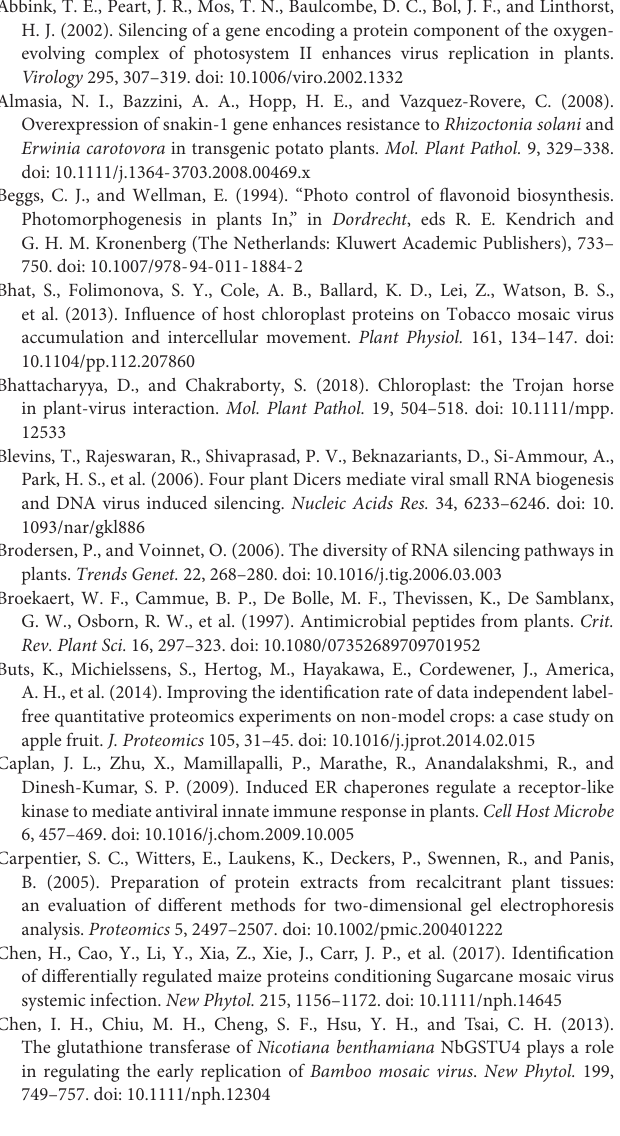
Supplementary Table 6 | Next generation sequencing (NGS) data showing the production of siRNAs in the dsRNAp126 + TMV treatment at 15 min post inoculation